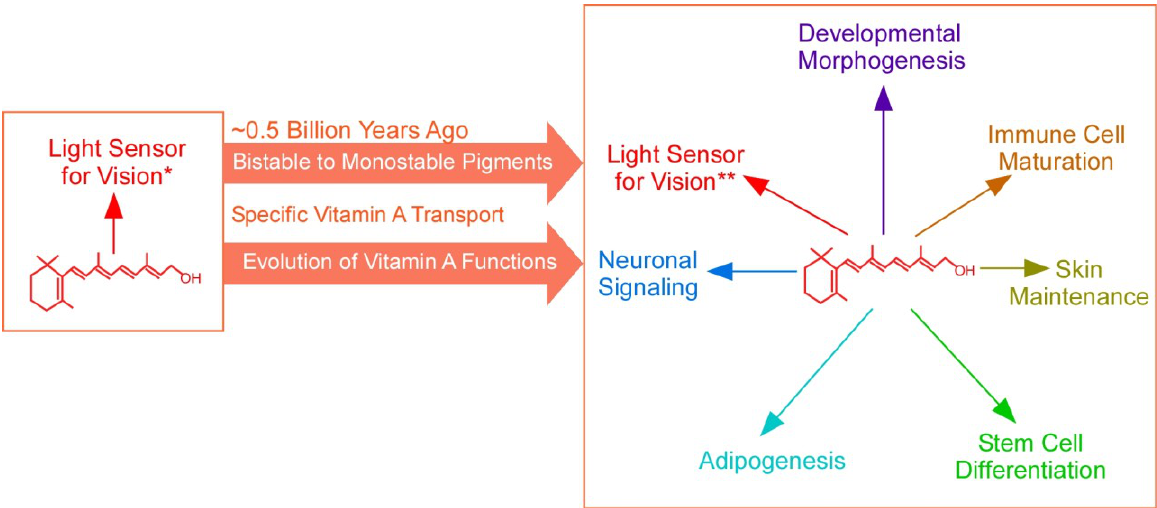
Figure 3. Summary diagram of the key events in the evolution of vitamin A functions that coincide with the emergence of RBP/STRA6-mediated specific vitamin A